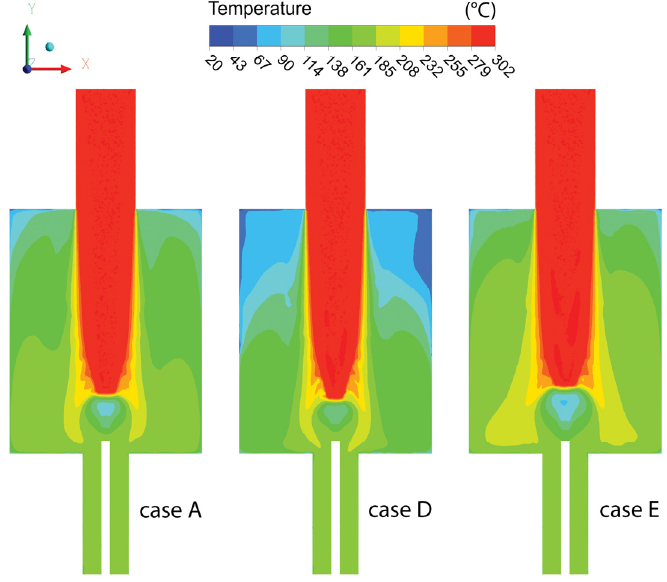
Figure 10. Temperature profile across the central axial cross-sectional plane (XY) for three different initial spray SMD, Case A = 48 µ m; Case D = 58 µ m; Case E = 38 µ m.